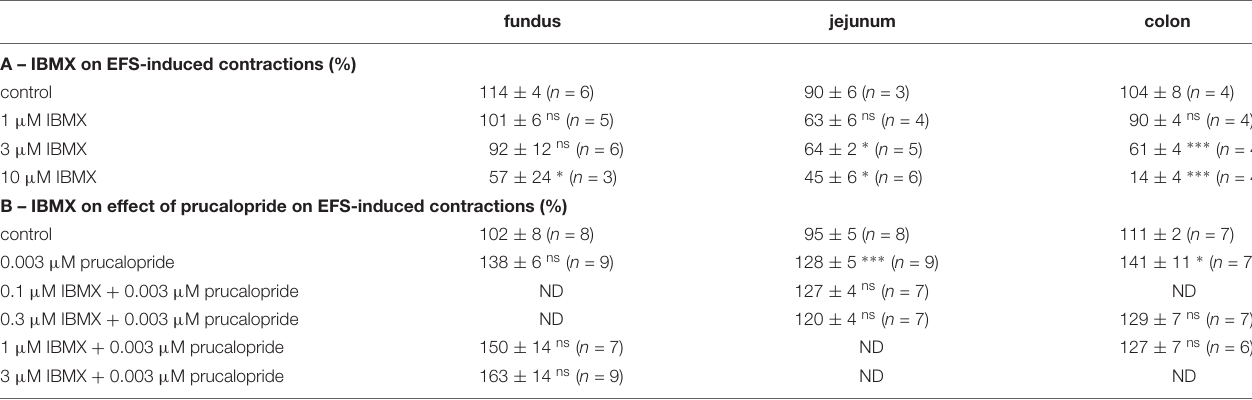
TABLE 1 | Influence of IBMX on EFS-induced submaximal cholinergic contractions (A) and on their facilitation by prucalopride (B) in murine fundus, jejunum, and colon. Mean ±